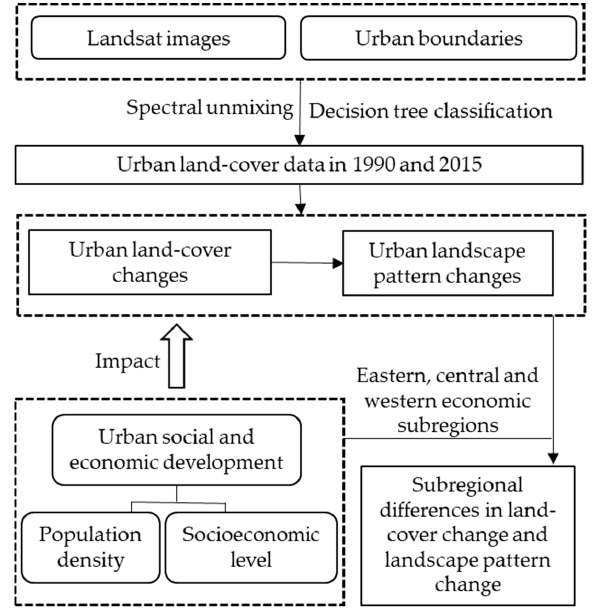
Figure 1. Conceptual framework of the study.